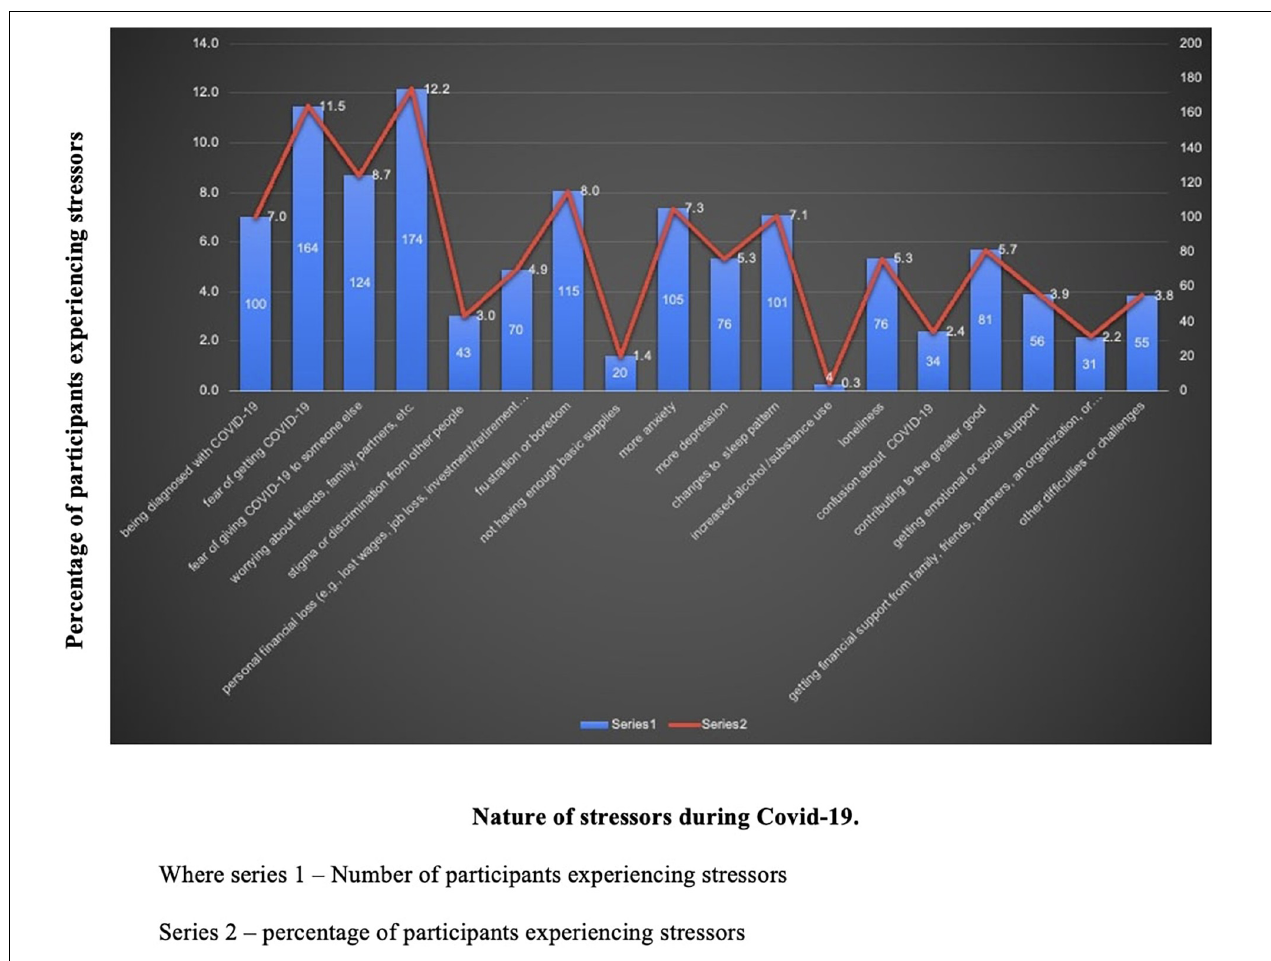
FIGURE 1 | Percent frequencies of experiences of different stressors during COVID-19